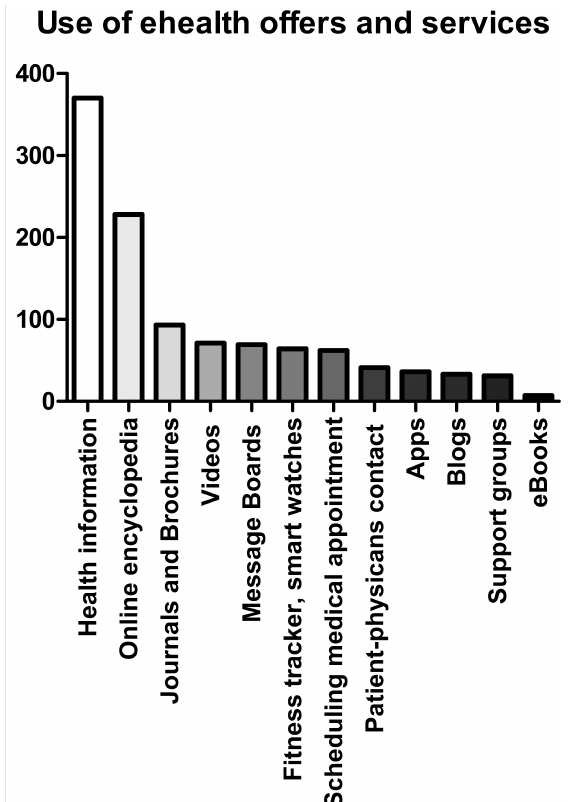
Figure 4. Use of eHealth offers and services. Total number of participants using eHealth offers and services categorized by the different outlets.